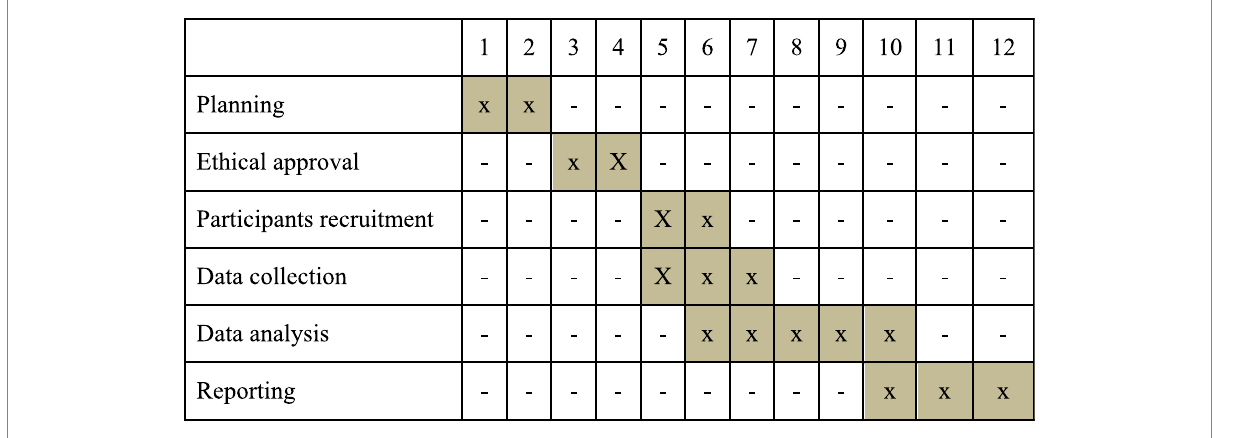
FIGURE 1 Project